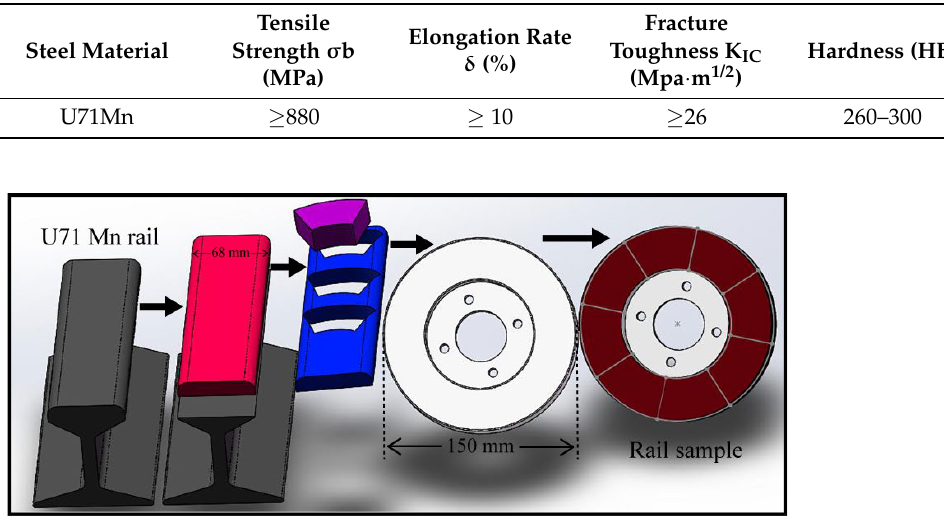
Figure 3. Preparation and morphology of rail sample .